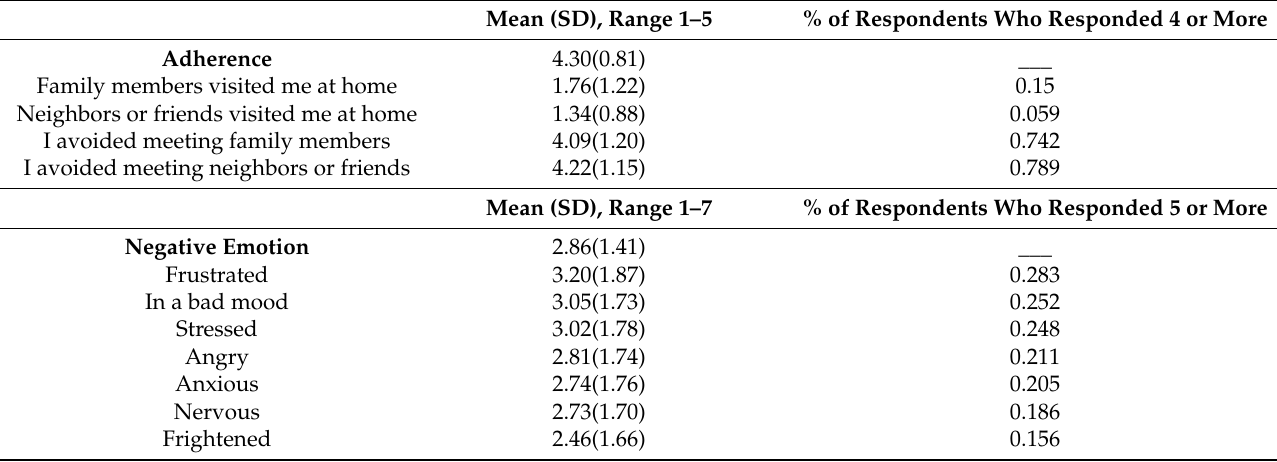
Table 1. Adherence with the instructions for physical/social distancing and negative emotions among the study population ( N =